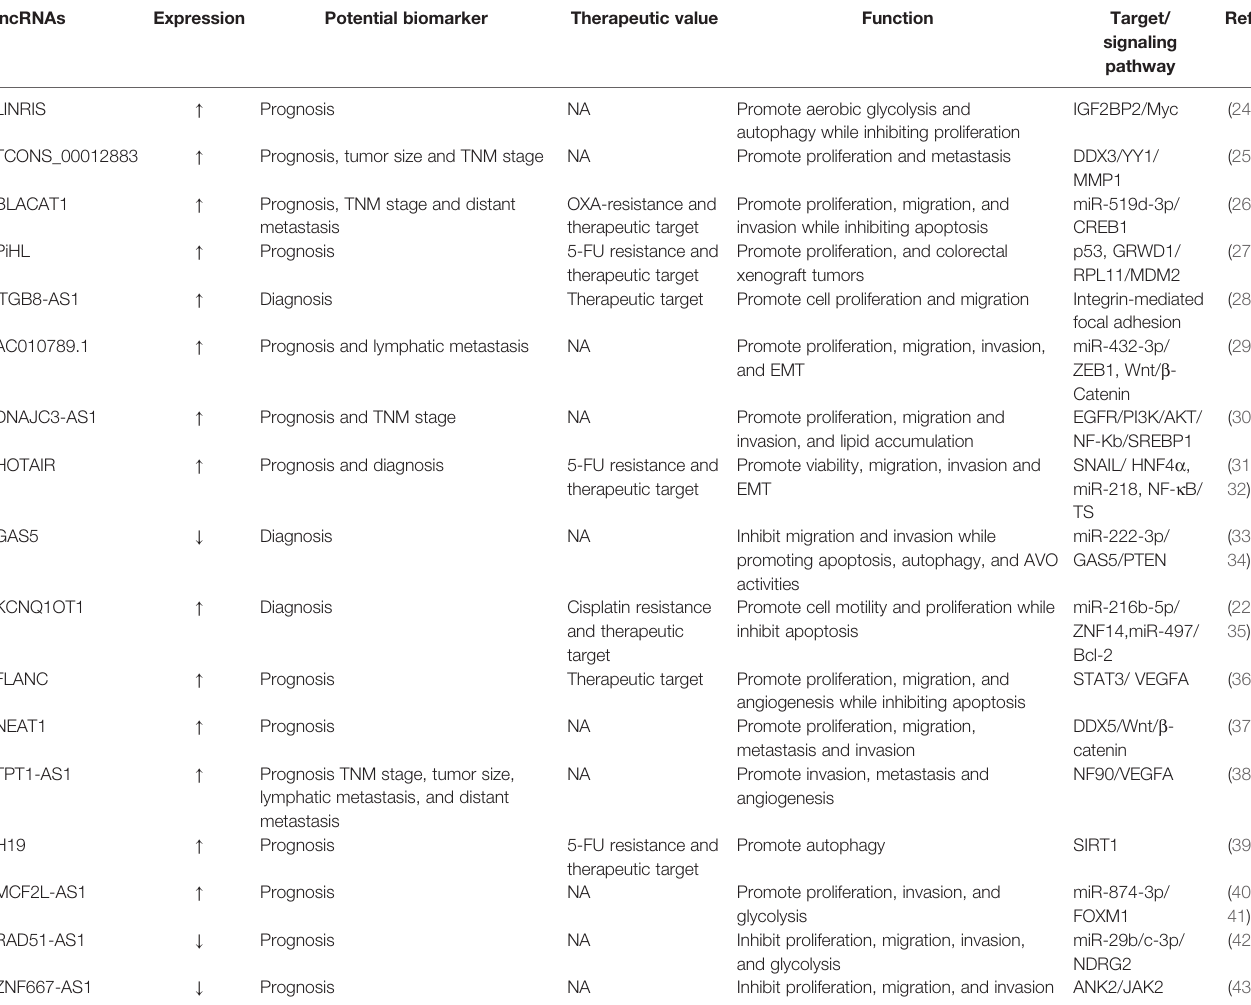
TABLE 1 | Selected examples of regulatory